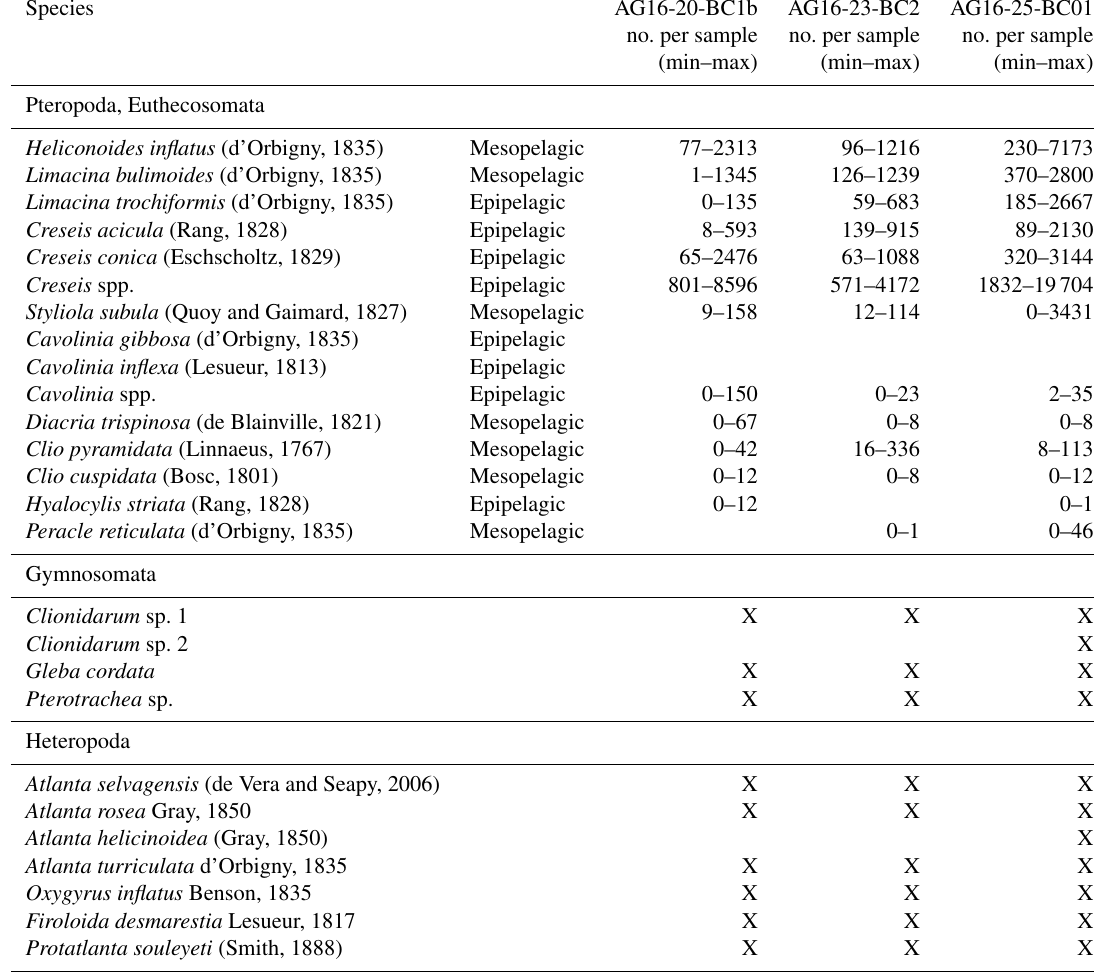
Table 2. Minimum and maximum abundances of pteropods and heteropods for each sample in the investigated cores. The number of pteropods per gram of sediment is reported in Supplement S1. X: presence of species or genera that have not been